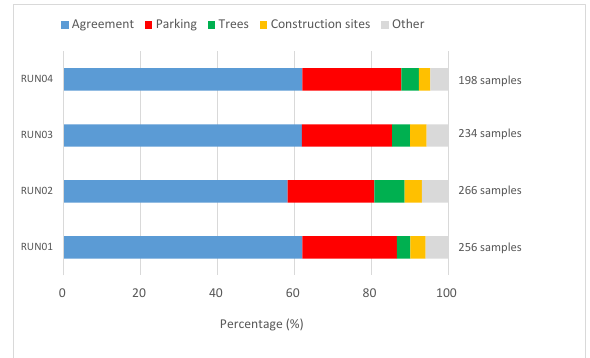
Figure 8: Validation of SAR-detected changes per building by photo interpretation of optical imagery. The percentage of agree- ment, i.e the SAR-detected changes confirmed by optical, is about 60 % (blue color) for all the considered RUNS. Disagree- ments are probably due to the occurrence of parking, 22% - 26% (red color), trees, 3.5% - 8% (green color), and construction sites, 3% - 4.5% (yellow color), nearby the SAR-detected buildings. The percentage of buildings in gray color (4.5% - 7%) represents the added value provided by SAR with respect to